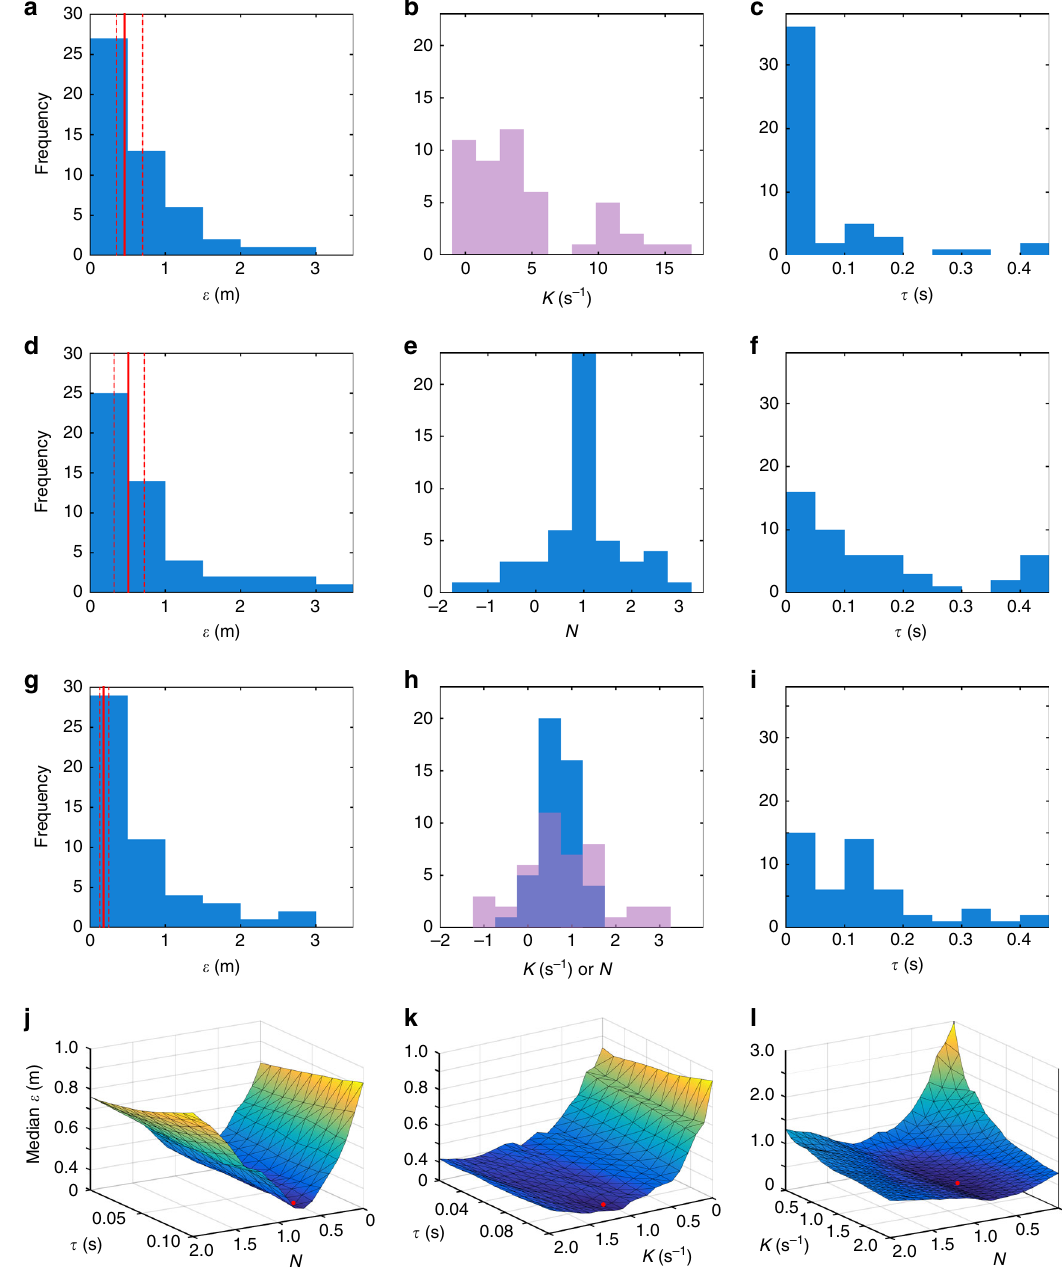
Fig. 5 Model parameters and fi t under each guidance law. a – c proportional pursuit (PP), fi tted independently to each fl ight; d – f proportional navigation (PN), fi tted independently to each fl ight; g – i mixed (PP + PN) guidance law, fi tted independently to each fl ight; j – l mixed (PP + PN) guidance law, fi tted globally to all fl ights. a , d , g histograms showing the prediction error ε of the best- fi tting model for each fl ight, where the solid and dashed red lines denote the median prediction error ~ ε and its bootstrapped 95% con fi dence interval; b , e , h histograms showing the best- fi tting guidance constant K (magenta) and/or N (blue) for each fl ight; c , f , i histograms showing the best- fi tting delay τ for each fl ight. j – l Surface plots showing how median prediction error ~ ε for all fl ights varies as a function of each pair of the parameters N , K and τ of the mixed guidance law, holding the third parameter constant at its best- fi tting value. Surface colour denotes surface height; red dot denotes location of global